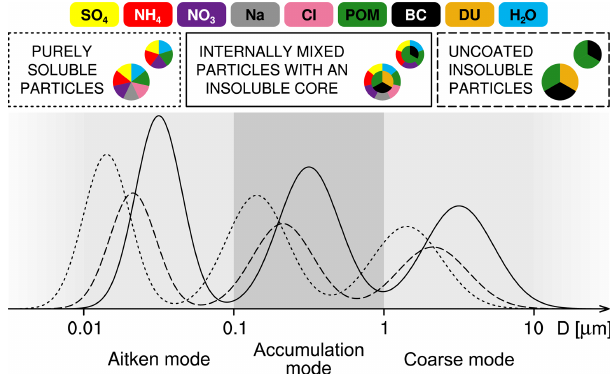
Figure 1. Schematic representation of the MADE3 submodel, as shown in Kaiser et al. (2019). The colours represent the different chemical components. The dotted, solid, and dashed lines corre- spond to the different mixing states (soluble, mixed, and insoluble, respectively). Grey shadings are to visually separate typical Aitken, accumulation, and coarse mode